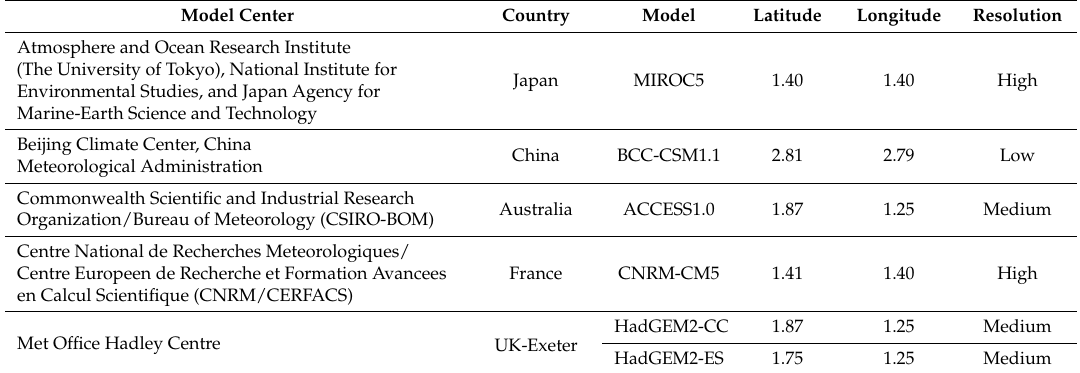
Table 1. Characteristics of the 6 General circulation models (GCMs) considered in this study. Model Center Country Model Latitude Longitude